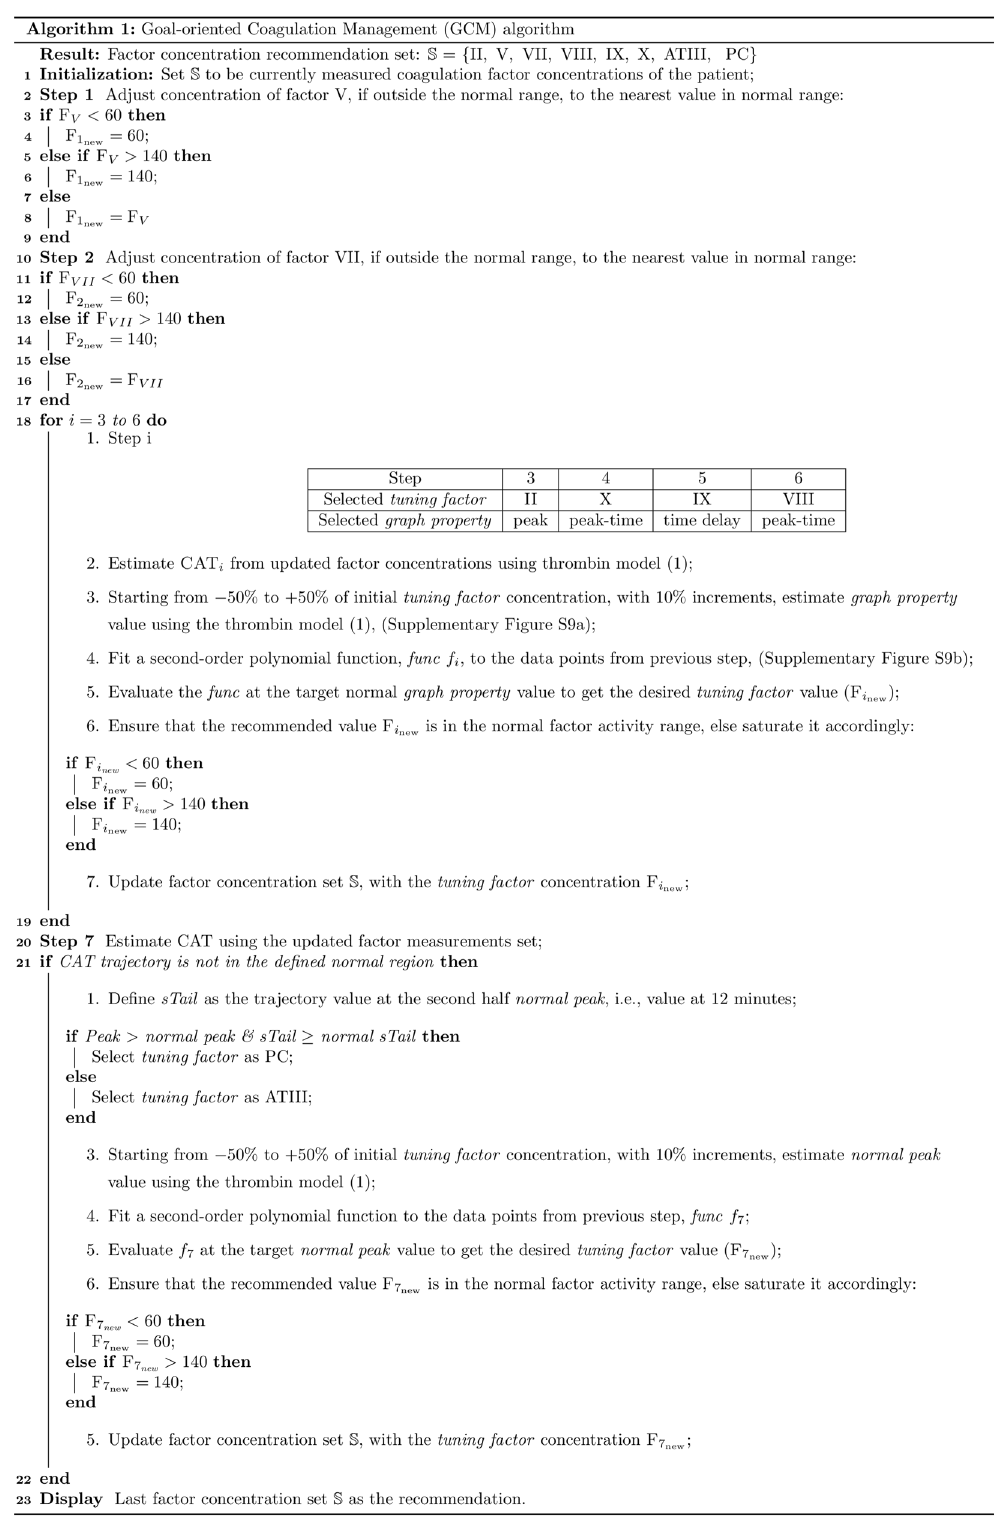
Fig. 7 The proposed GCM algorithm enables frequent, dynamic, and personalized TIC treatment. This algorithm systematically recommends coagulation factor concentrations to move a patient CAT trajectory toward normal, while also maintaining concentration values within normal activity ranges. This algorithm serves as the controller block in Fig.